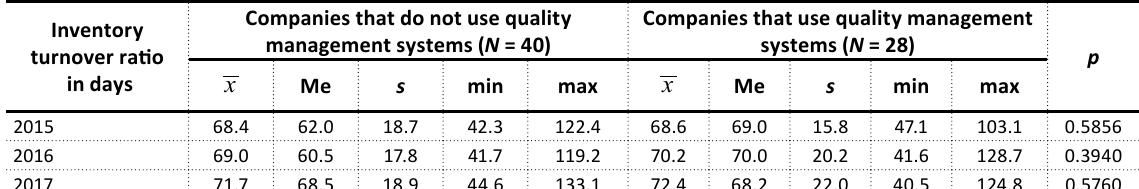
Table 2. Average results for the inventory turnover ratio in days in the analyzed enterprises